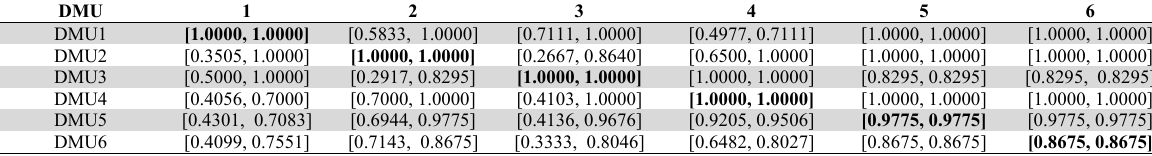
Cross-efficiency intervals matrix (CEIM) of six nursing homes DMU